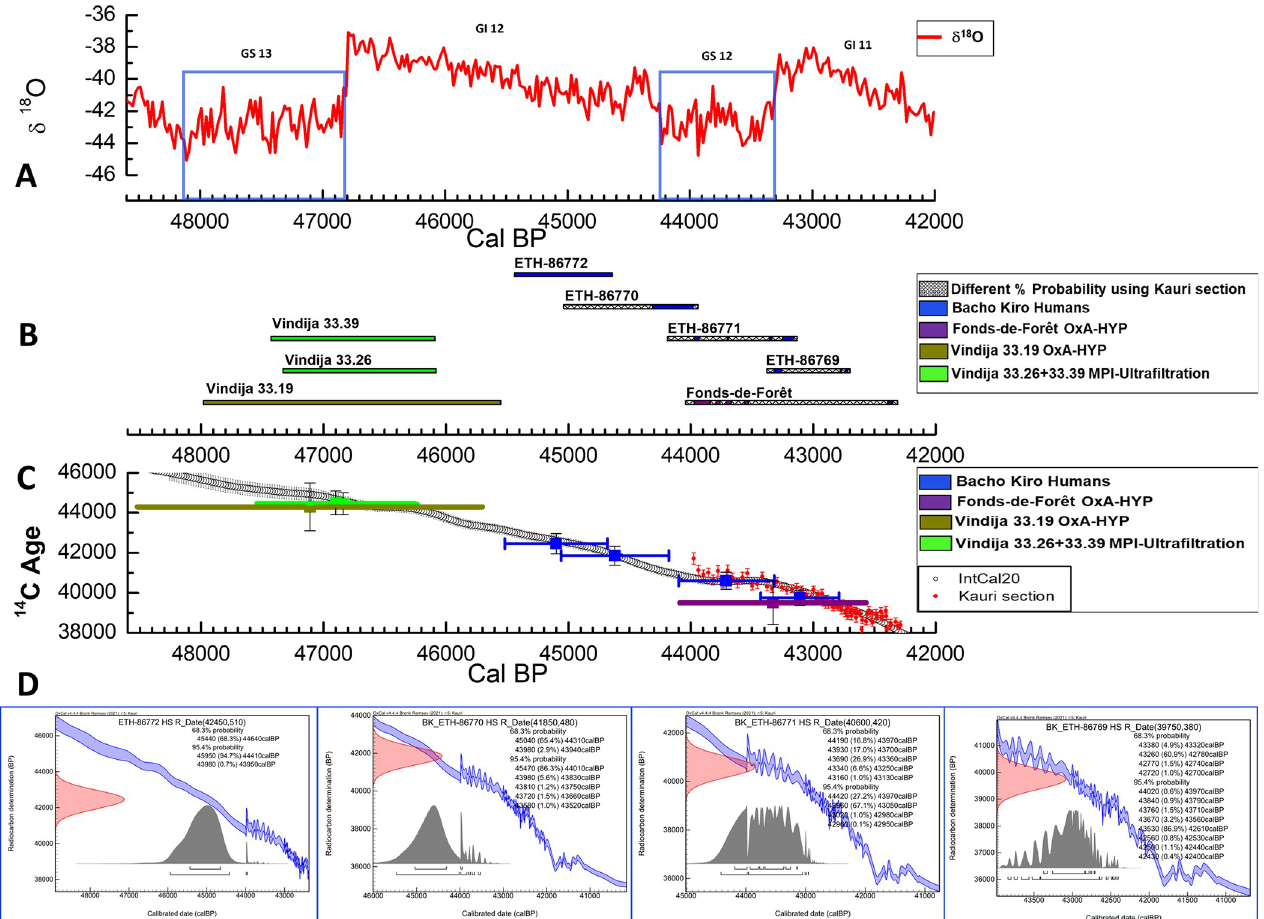
Fig 1. 14 C error range and Kauri floating curve. A) the red curve represents the climatic events using the data of δ 18 O, and the terminology of the interstadial (GI) and stadial (GS) events of the Greenland ice cores published [59], in blue squares indicate the cold phases of GS13 and GS12; in the black square on the right the entire sequence of the NGRIP from 49,000 to 42,000 cal BP. B) the calibrated ranges obtained by the direct radiocarbon dates on 4 Homo sapiens (Bacho Kiro) and 4 Neanderthals (Vindija and Fonds-de-For ê t) fossils [6, 22, 35, 62]. C) the mean with the relative 1 σ error produced by OxCal for the human fossils dated on the IntCal20 calibration curve [31] in black and on Kauri floating section [18] in red. D) the calibrated ranges using IntCal+Kauri obtained using the OxCal 4.4 program [58].